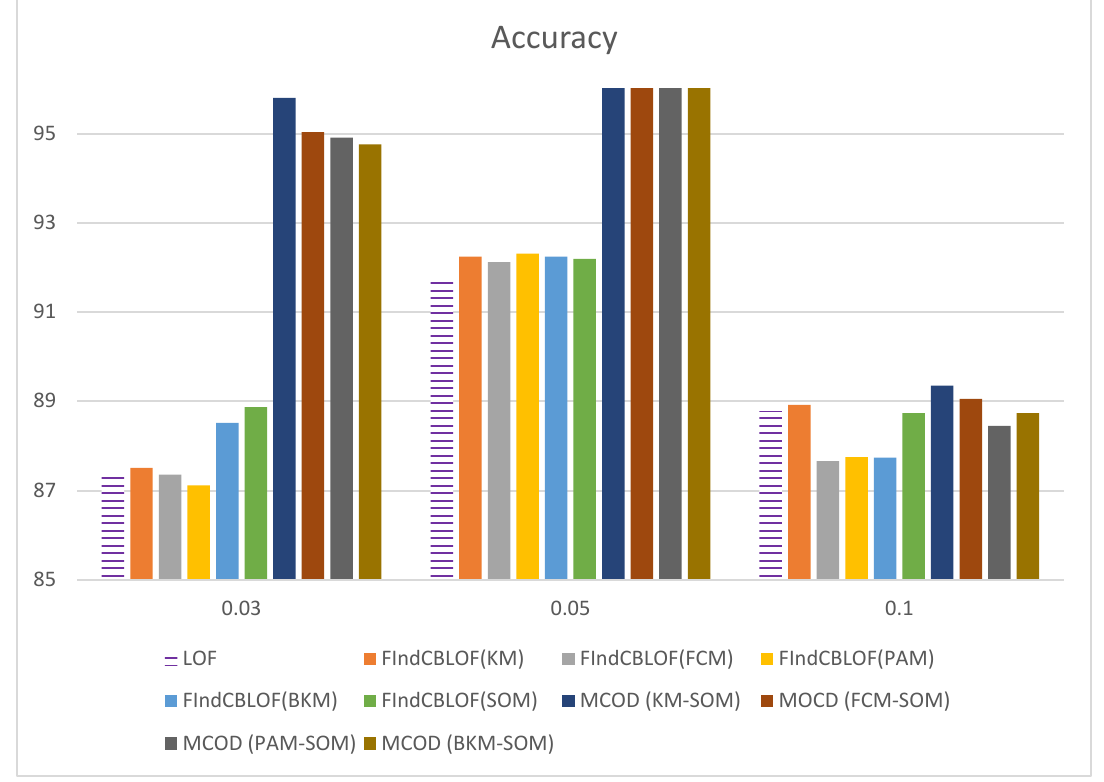
Figure 3. Detection Accuracy (RBC Dataset).